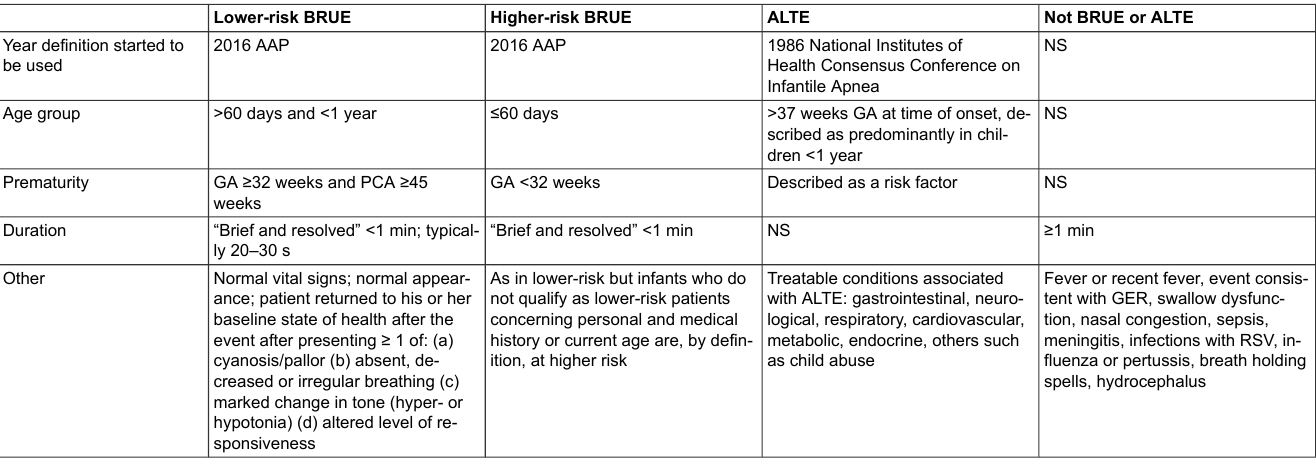
Table 1: Comparison of definitions of ALTE and